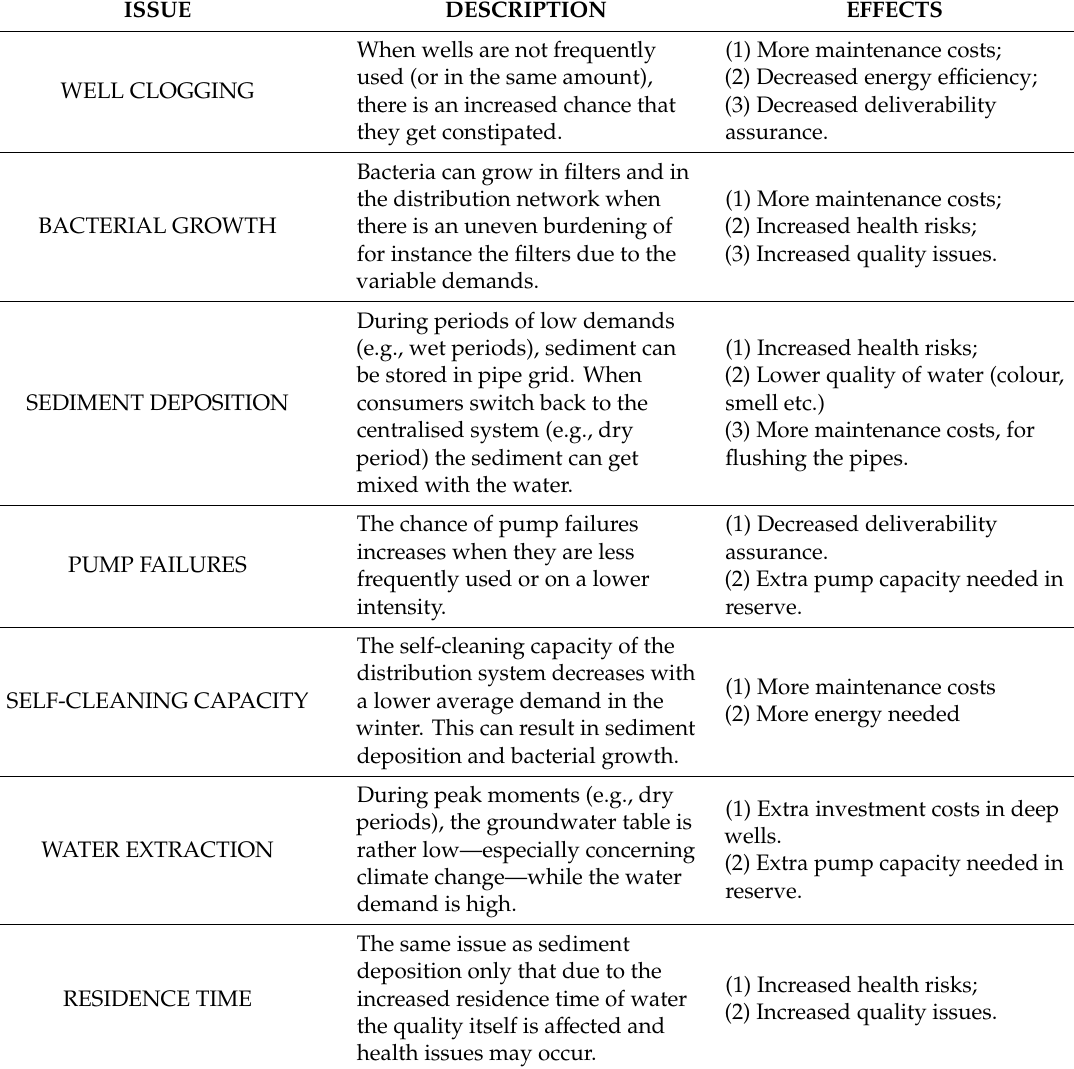
Table 6. Problems in the centralised system in the LF-extreme